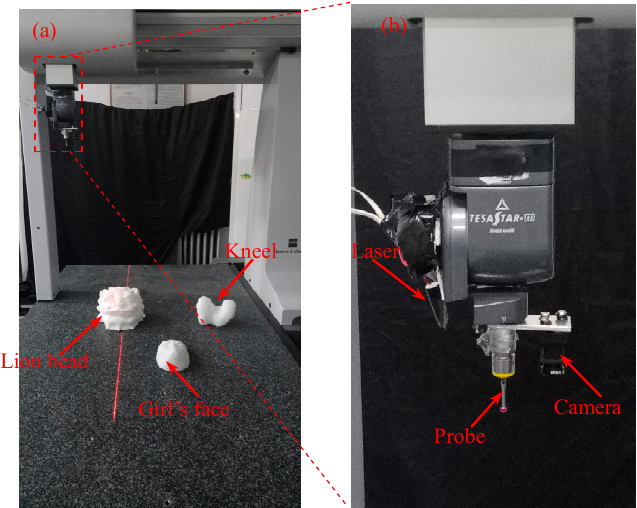
Figure 6. The actual experiment equipment includes coordinate measuring machine, measured workpiece and visual system, ( a ) the overall physical diagram, ( b ) the partial magnification of probe and visual system.